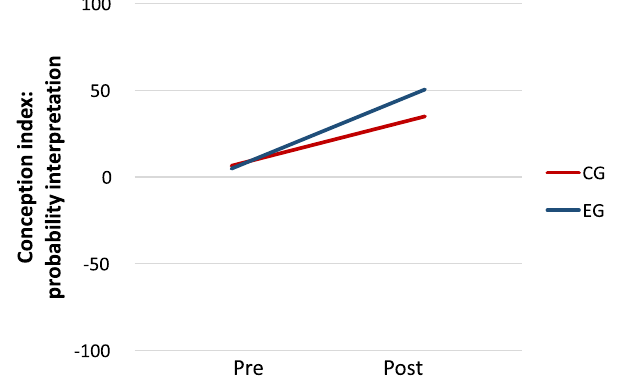
FIG. 9. We find a stronger increase of the mean conception index for the probability interpretation of quantum physics from pre- to postsurvey in the experimental group than in the control group.